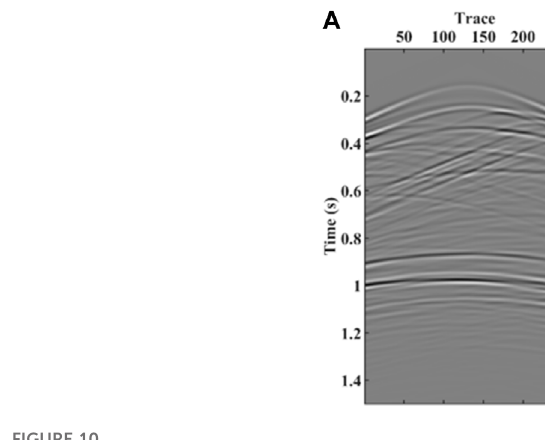
Synthetic Seismic Data. (A) Noise-free data; (B) Noisy